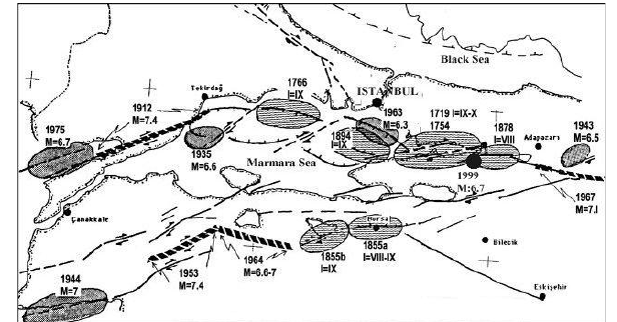
Fig. 2. Historical Earthquake Map of the Marmara Region (Barka,